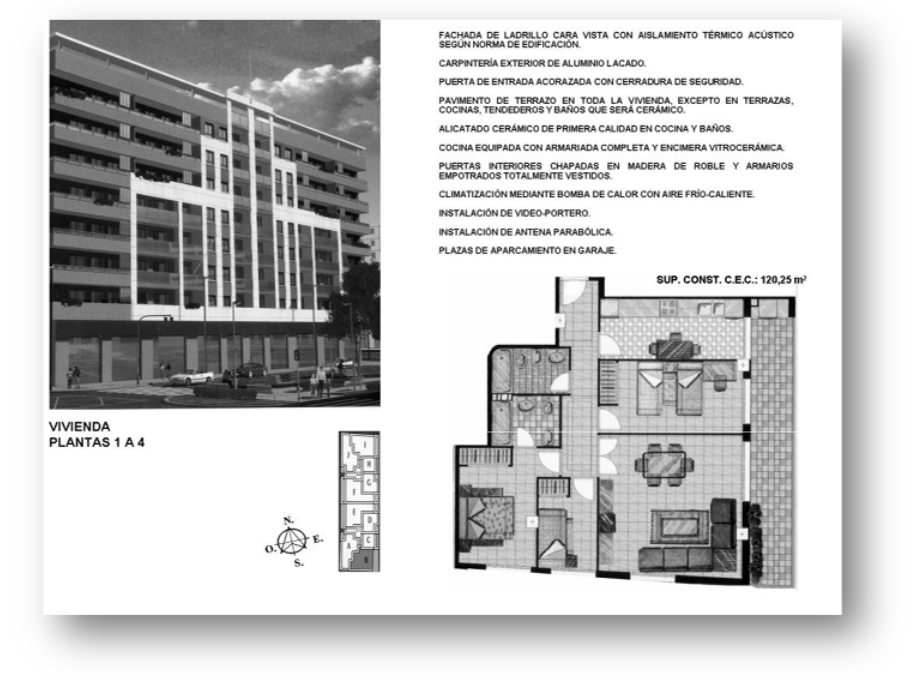
Figure 2. “Stimulus of a particular flat”. Source: authors